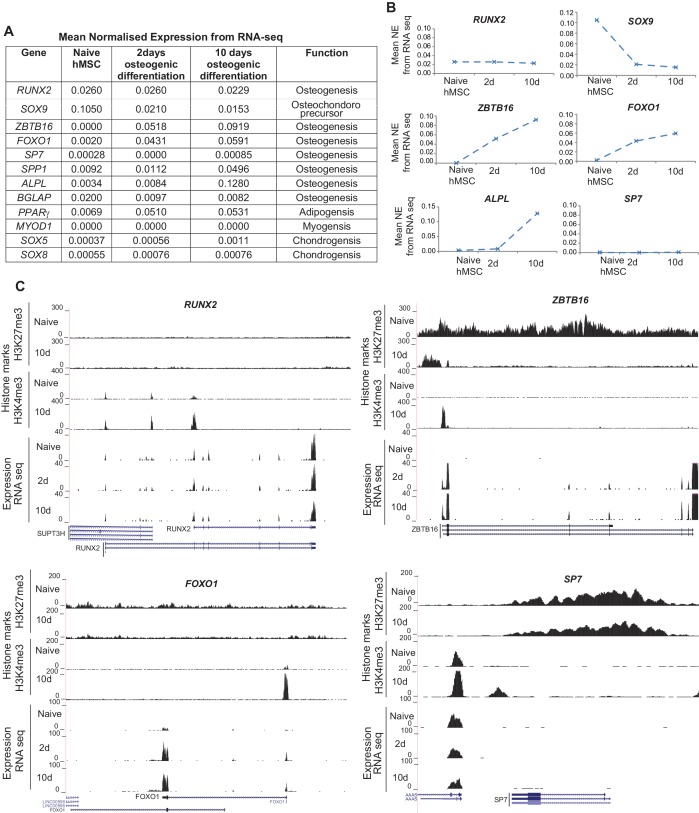
(A) The table shows the mean normalized expression (NE) values for indicated TF and markers obtained from RNA-seq during osteogenic differentiation of hMSCs based on three biological replicates.(B) On the right hand side, the mean normalized expression values ± SD are plotted and represented as graphs for selected genes. (C) Genome browser tracks showing histone marks obtained from ChIP-seq and expression from RNA-seq for selected gene loci in niave hMSCs and after induction of osteogenic differentiation at the indicated time points. RUNX2, Runt related transcription factor-2; ZBTB16, Zinc finger and BTB domain containing 16; FOXO1, Forkhead box O1; SP7, Transcription factor 7/Osterix.